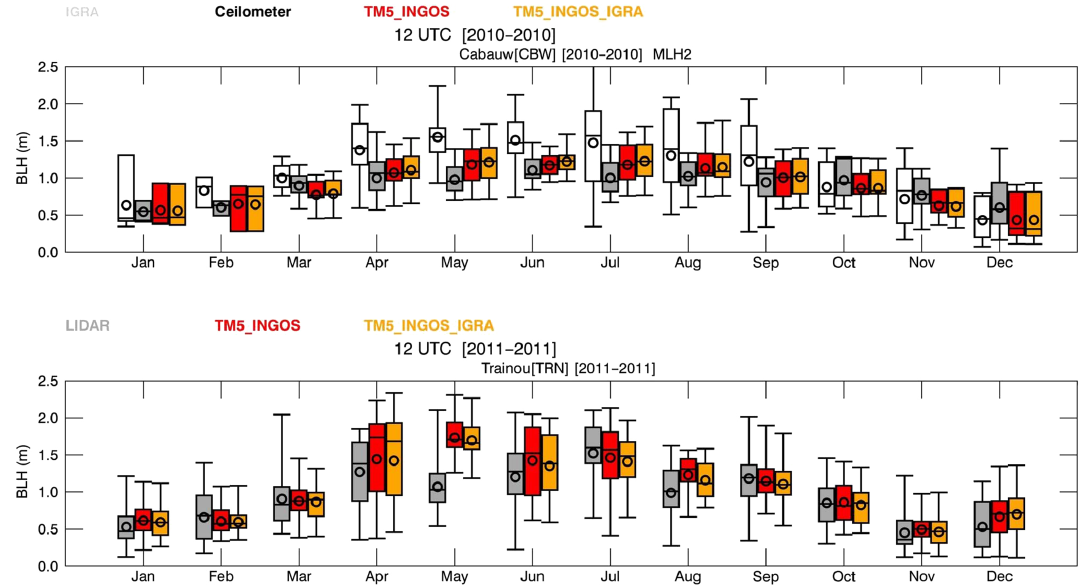
Figure 5. As in Fig. 3, but on the top Cabauw (CBW) where both ceilometer and nearby IGRA observations (from De Bilt) are available. Observed (IGRA in blank; ceilometer in grey) and simulated (colours) boundary layer heights at 12:00UTC and for 2010 are shown. On the bottom, Traînou (TRN) lidar-based boundary layer heights (grey) at 12:00UTC during 2011 are shown. The model boundary layer heights are represented by the coloured boxes (for the different acronyms see Sect.